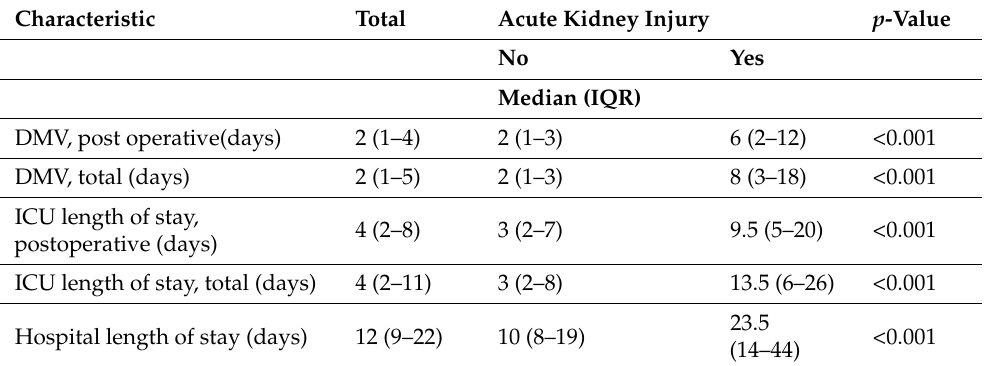
Table 5. Clinical outcomes according to AKI.